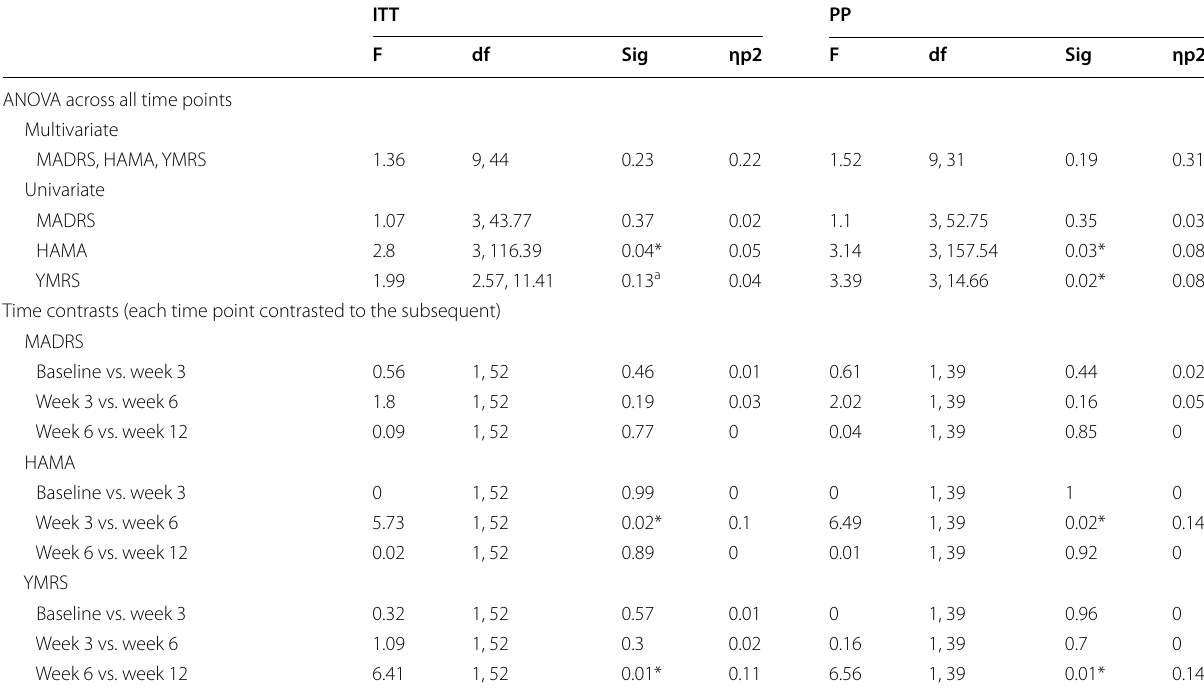
Table 3 ANOVA time * group interaction